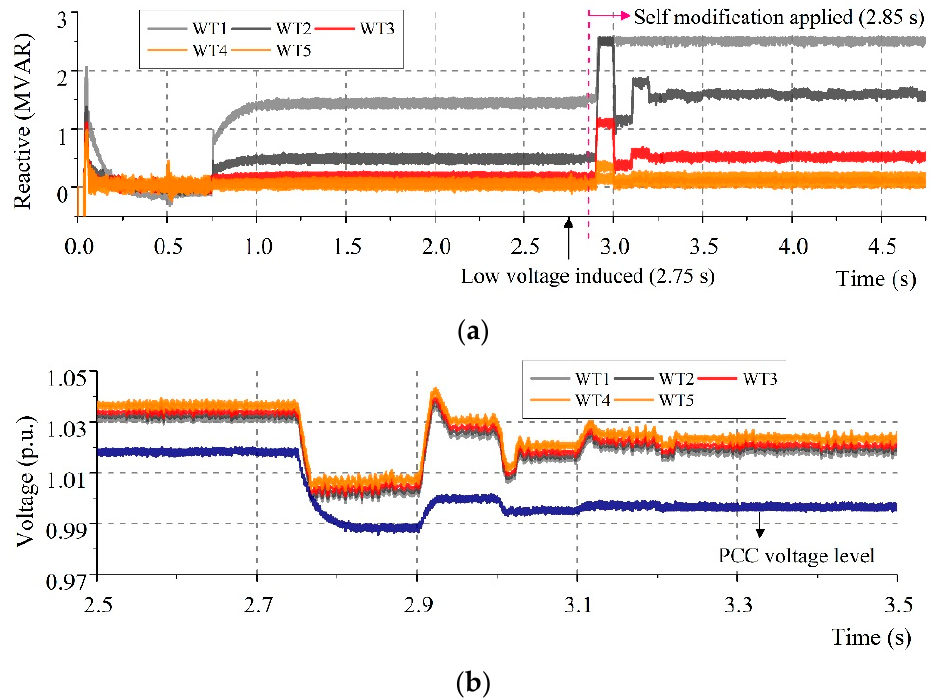
Figure 10. Reactive power supply from array 1 and voltage condition in case B—modified algorithm, with ( a ) reactive power supply, and ( b ) voltage variation.